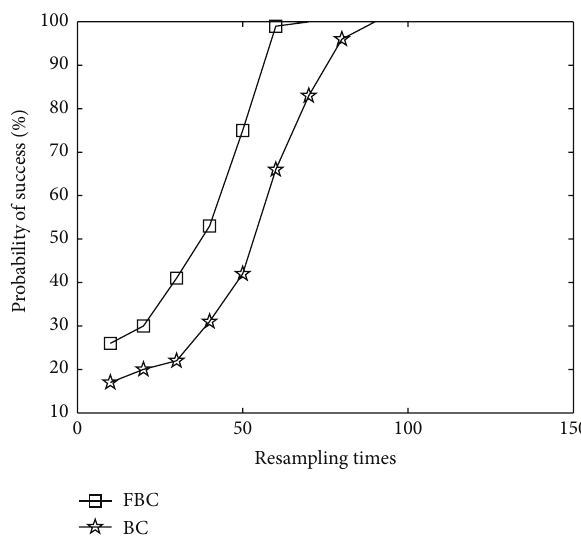
Figure 8: Probability of success versus resampling